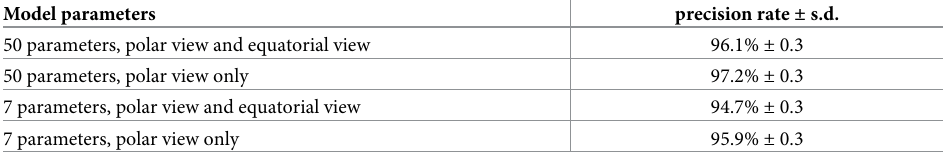
Table 3. Cross-validation results of Support Vector Machine to predict pollen type, based on 99 iterations of ran- dom 80:20 splits of data into training:test sets. Model